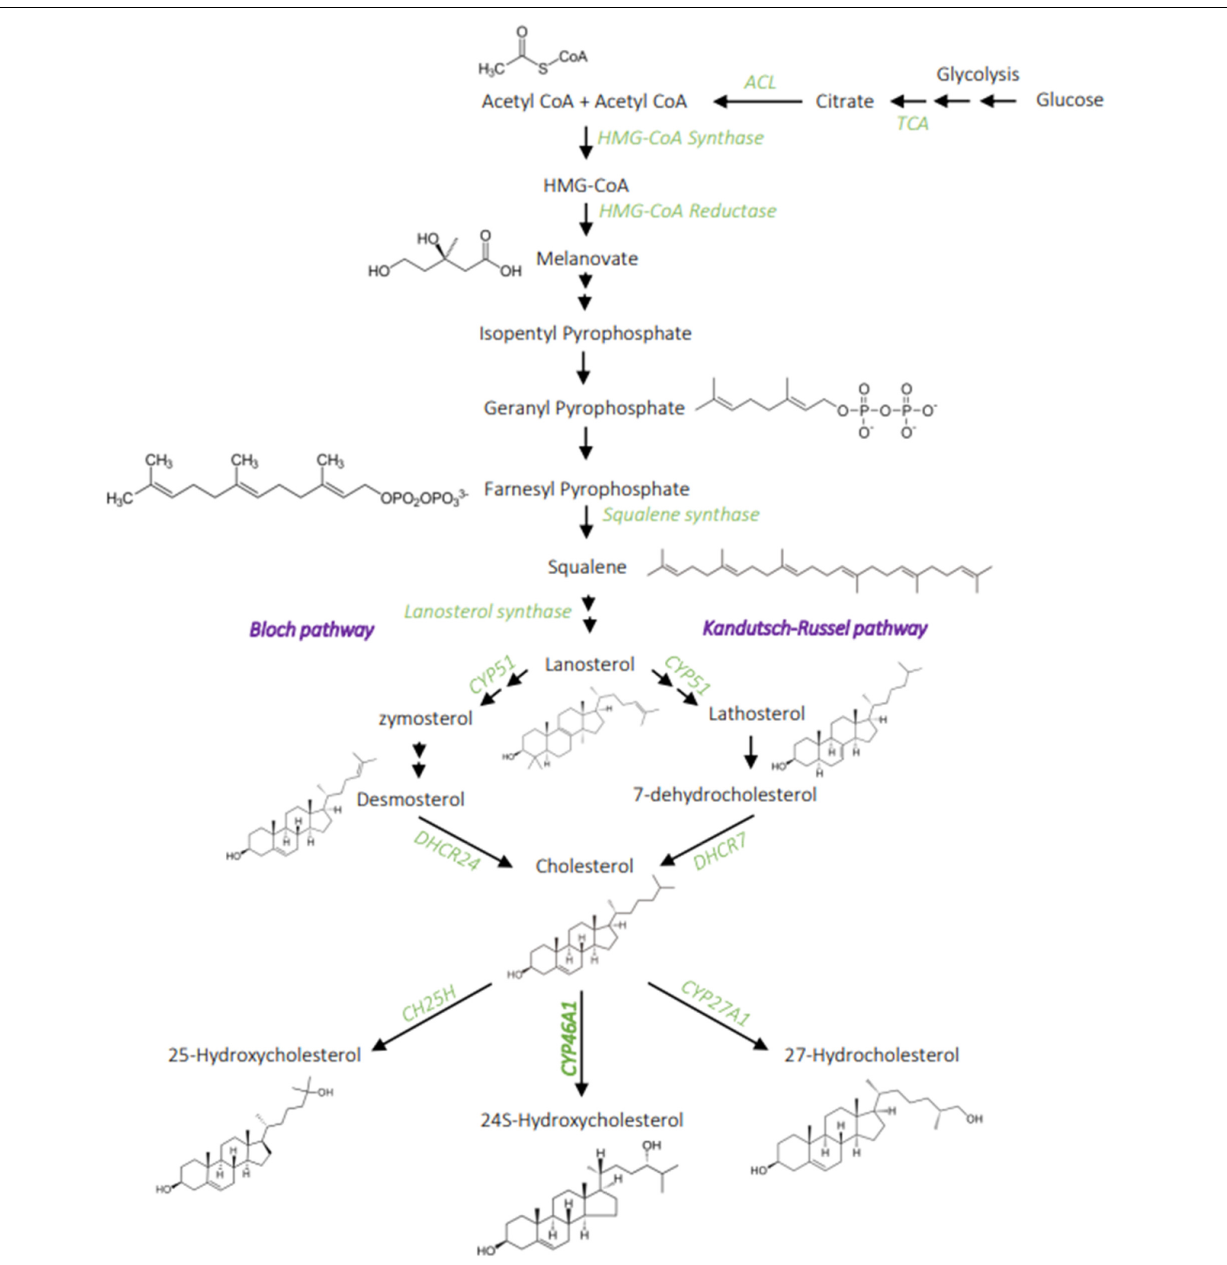
FIGURE 1 | Cholesterol metabolism. Cholesterol synthesis involves a complex chain of enzymatic reaction, from acetyl-CoA to the melanovate pathway that then divides into two possible pathways: the Bloch and Kandutch-Russel. The main product of cholesterol hydroxylation in the brain is the 24S-hydroxycholesterol, it can also be hydroxylated into 27-hydroxycholesterol and 25-hydroxycholesterol to a lesser extent. ACL, ATP citrate lyase; TCA, tricarboxylic acid cycle; CH25H, Cholesterol 25 hydroxylase; CYP51, lanosterol 14 alpha-demethylase; DHCR7, 7-dehydrocholesterol reductase; DHCR24, 24-dehydrocholesterol reductase; CY46A1, cholesterol 24-hydroxylase. Created with